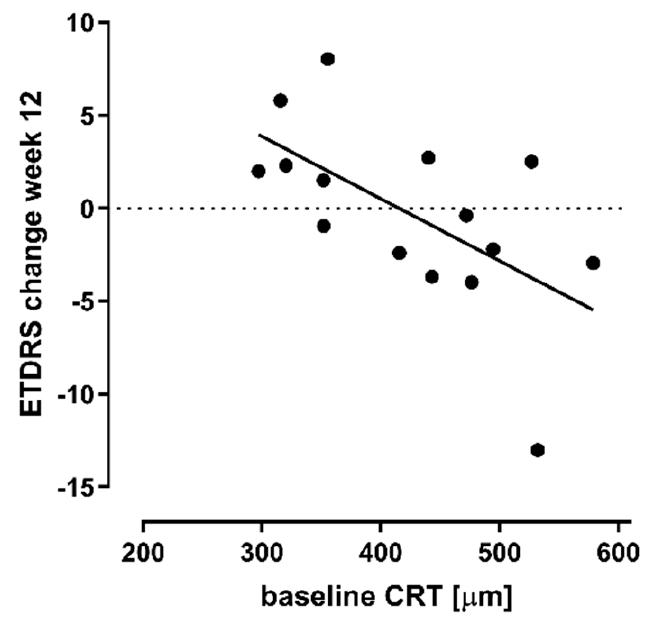
Figure 2. Early Treatment Diabetic Retinopathy Study (ETDRS) letter change from baseline to week 12 plotted against values of baseline central subfield retinal thickness (CRT). Eyes with less severe diabetic macular edema and thinner retinas (less CRT) at baseline experienced more gain in vision than those with thicker retinas. (Regression line: ETDRS change = − 0.033 × (baseline CRT) + 13.9; r2 = 0.36; p = 0.017).